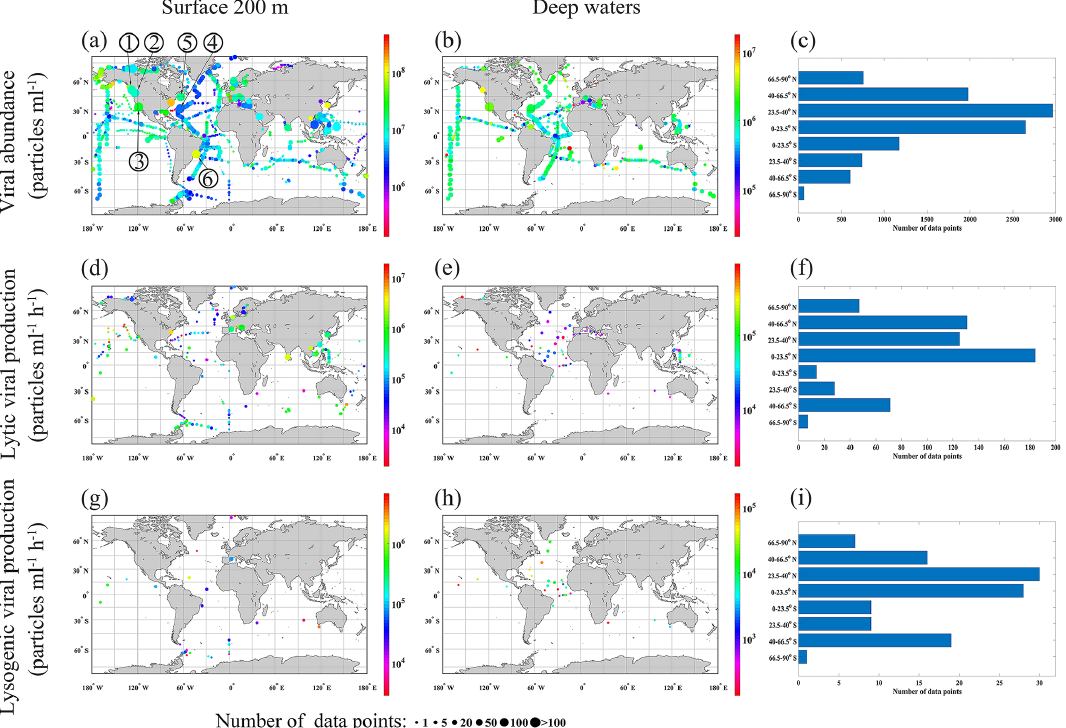
Figure 1. Collected viral abundance (a, b) , lytic viral production (d, e) and lysogenic viral production (g, h) in surface ( ≤ 200m) ( a , d and g ) and in deep ( > 200m) waters ( b , e and h ), binned on 1 ◦ × 1 ◦ grids. Color of each grid codes the mean value of the parameters, and the size of the circles represents the number of samples in each bin. Also shown is the number of samples in latitudinal bands ( c , f and i ). Numbers in panel (a) represent long-term time-series observations of viral abundance: 1 – Rivers Inlet, 2 – Saanich Inlet, 3 – San Pedro Ocean Time Series Microbial Observatory, 4 – Bedford Basin Plankton Monitoring Program, 5 – Bermuda Atlantic Time-series Study, and 6 – Guanabara